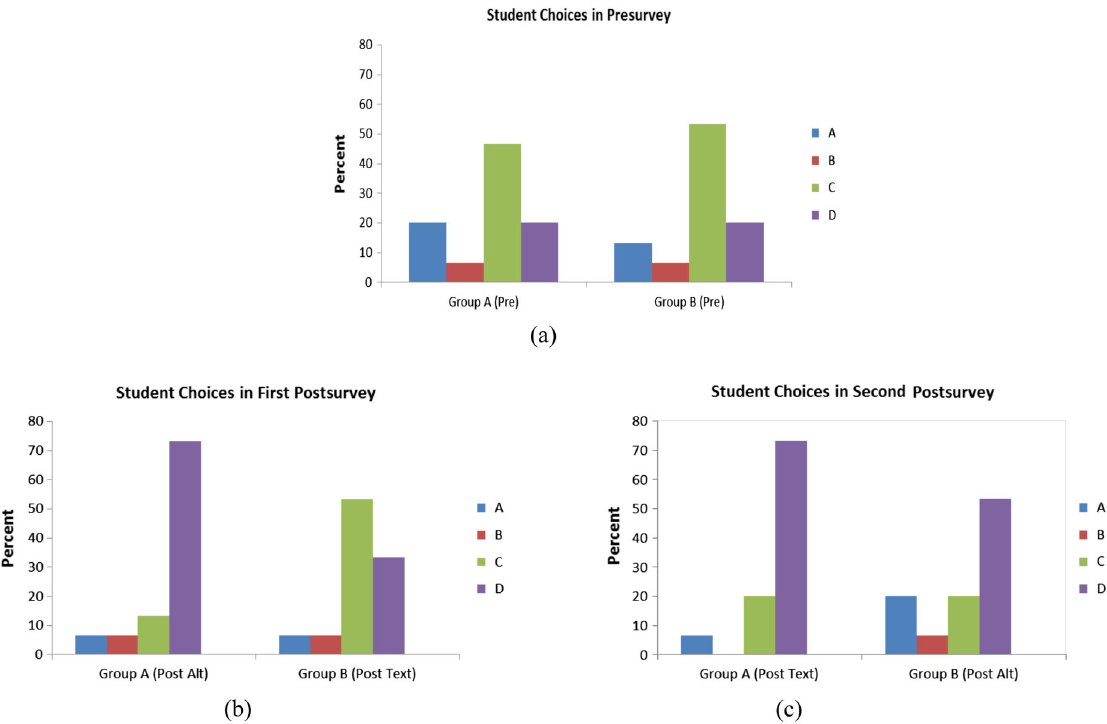
FIG. 6. Percentages of students in group A and group B choosing options A through D in question 3 in the Presurvey and question 4 in the first and second postsurveys.